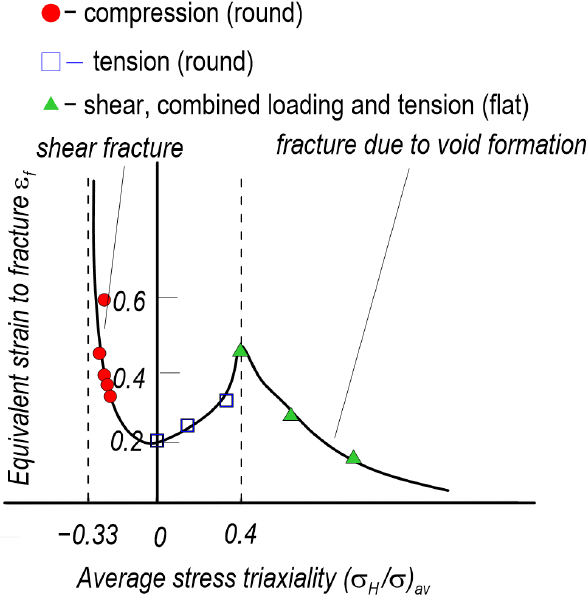
Figure 17. Numerically and experimentally determined dependence between critical plastic strain and the level of stress triaxiality factor (for 2024-T351 aluminium alloy) [139]. The influence of the Lode parameter value on the void growth and coalescence process has formed the basis of a number of papers [92,137,140–144]. Barsoum and Faleskog pro- posed a micromechanical model based on experimental studies and numerical calculations of a three-dimensional elementary cell containing a single spherical void [145]. The macro- scopic stress state was defined by two variable quantities: the stress triaxiality factor and the Lode parameter. On the basis of the results obtained, it was determined that the effect of the Lode parameter on the change in the shape of voids and the rate of their growth increases as the level of the stress triaxiality factor decreases. For a stress triaxiality factor of T = 1, there is an increase and a change in the shape of the void due to shear strain. The void undergoes a change in shape from spherical to ellipsoidal, up to the onset of plastic localisation, so as to further obtain a ‘penny’ shape. For triaxiality stress level 2, there is an almost spherical increase in voids. The influence of the triaxiality parameter and Lode on the formation of plastic localisation was also determined. High values of the T parameter were accompanied by low levels of critical strain. The minimum value of critical strain occurred at a triaxiality factor of 0, while the maximum value occurred at T = 1. This marks the shear state as the most critical state from the point of view of destruction,